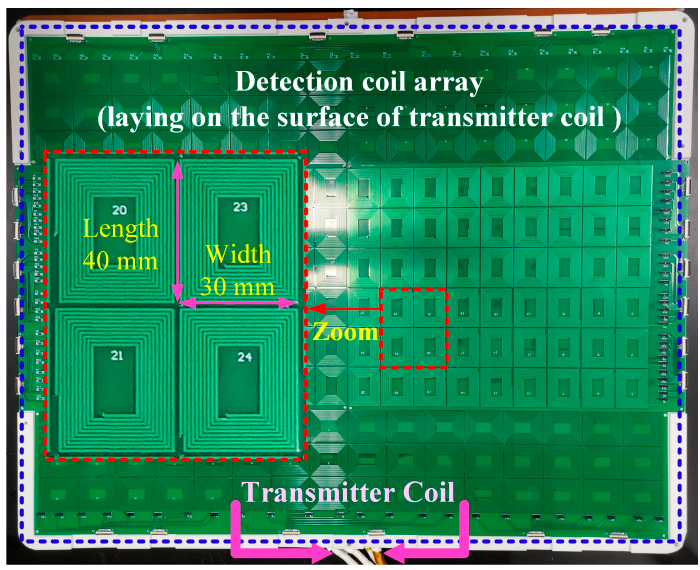
Figure 8. Detection coil array laid on the surface of the transmitter coil.